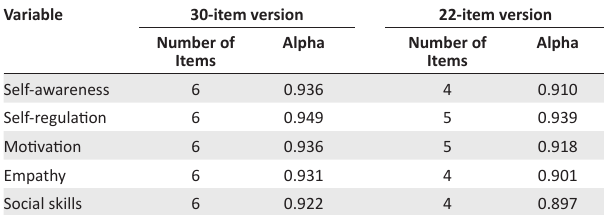
TABLE 5: Reliability estimates (Sample 2, n =